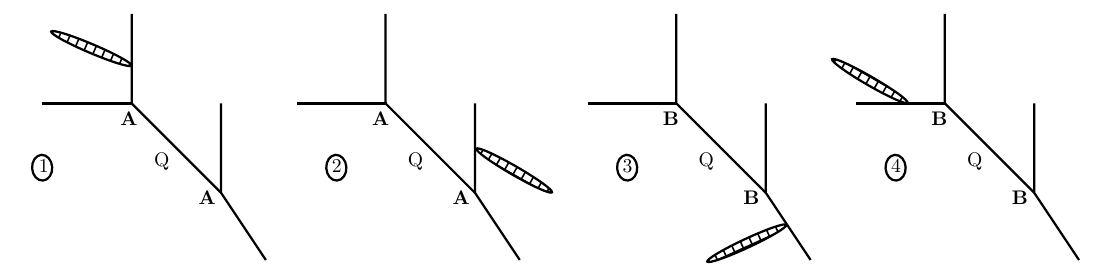
Figure 6: Toric diagram for a resolution of (cid:67) 3 / (cid:90)